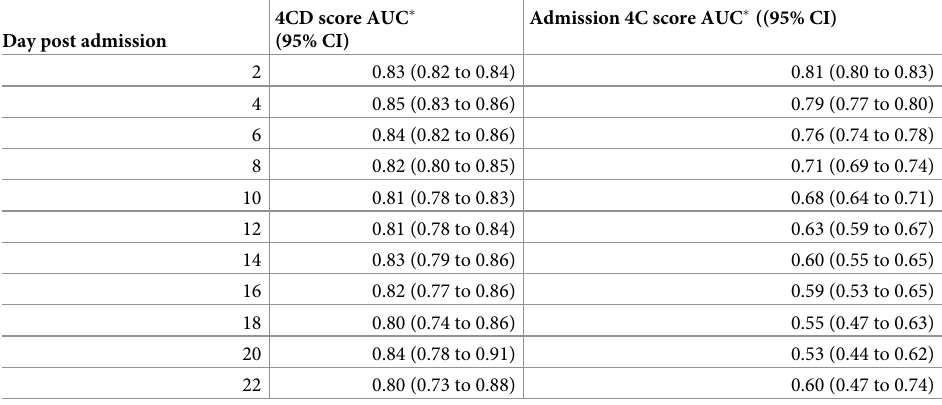
Table 3. Area under the curve of the receiver operating characteristic using 4CD score calculated every 2 days compared to 4C score on admission in all patients alive and not in ICU, with 95% Confidence